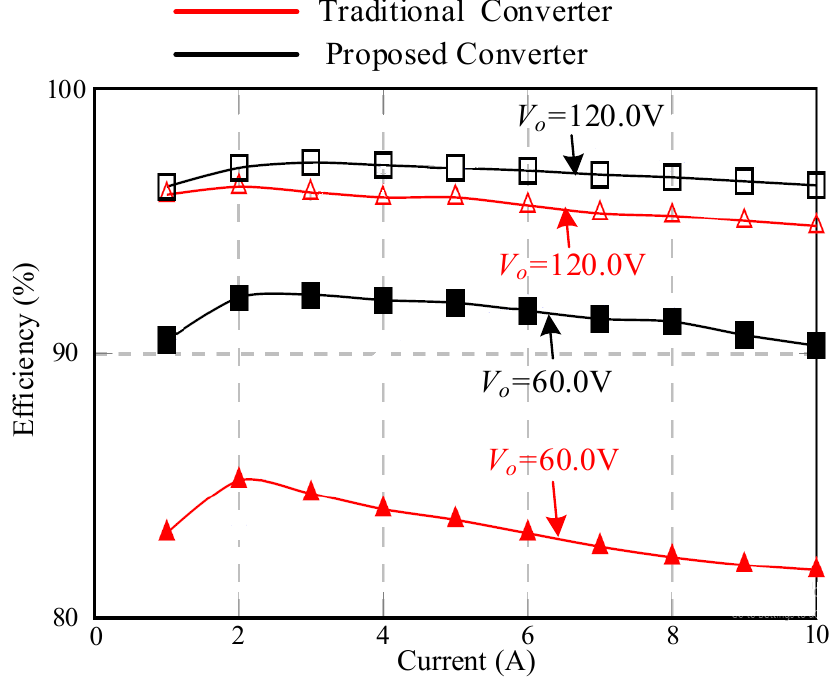
Figure 7. Efficiency waveforms of the two LC-DAB Converters.